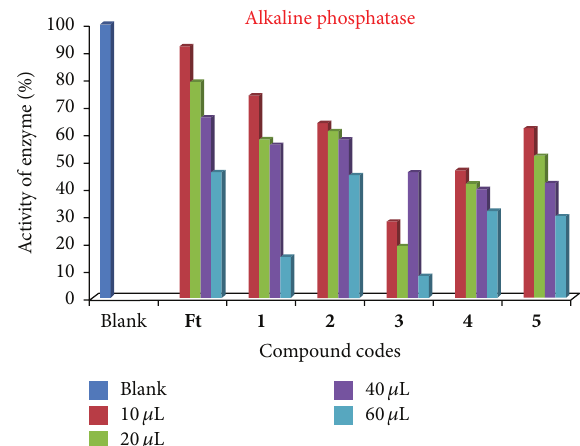
Figure 6: Enzymatic studies (alkaline phosphatase) of compounds Ft and 1 – 5